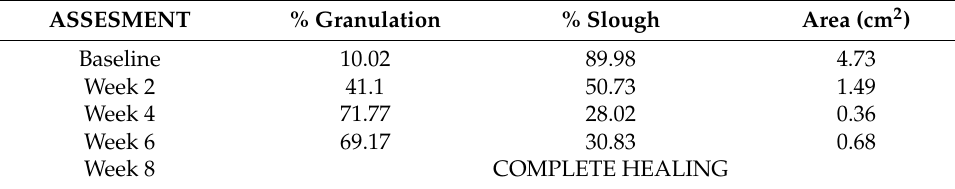
Figure 4. Evolution of tissue types. Case 2. Table 3. Evolution in percentage of tissue types and areas Case 2. ASSESMENT